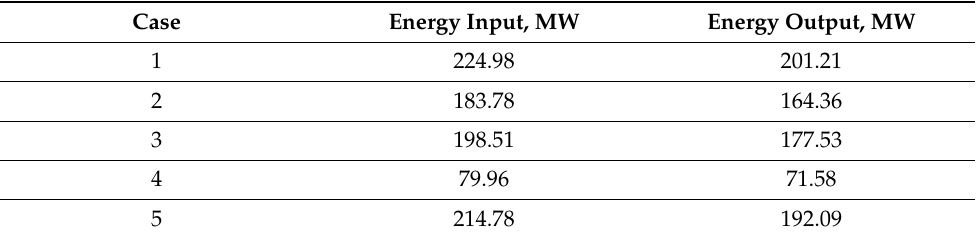
Table 3. Energy input at the propane tank in reference conditions: 257.95 K and 0.2 MPa and energy output in reference conditions: propane vaporiser at 271.75 K and 0.4